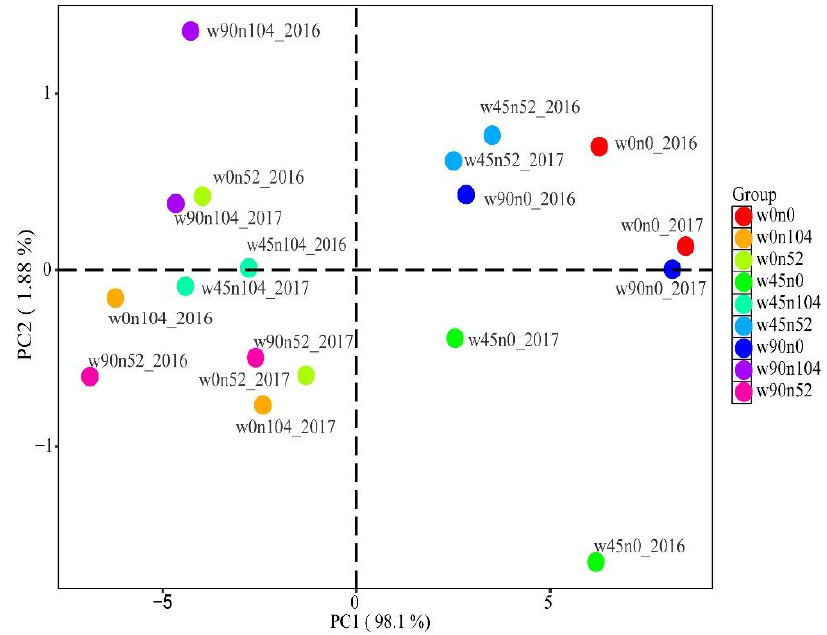
Figure 10. Principal component analysis of eight indicators on irrigation and fertilization amount in 2016 and 2017.